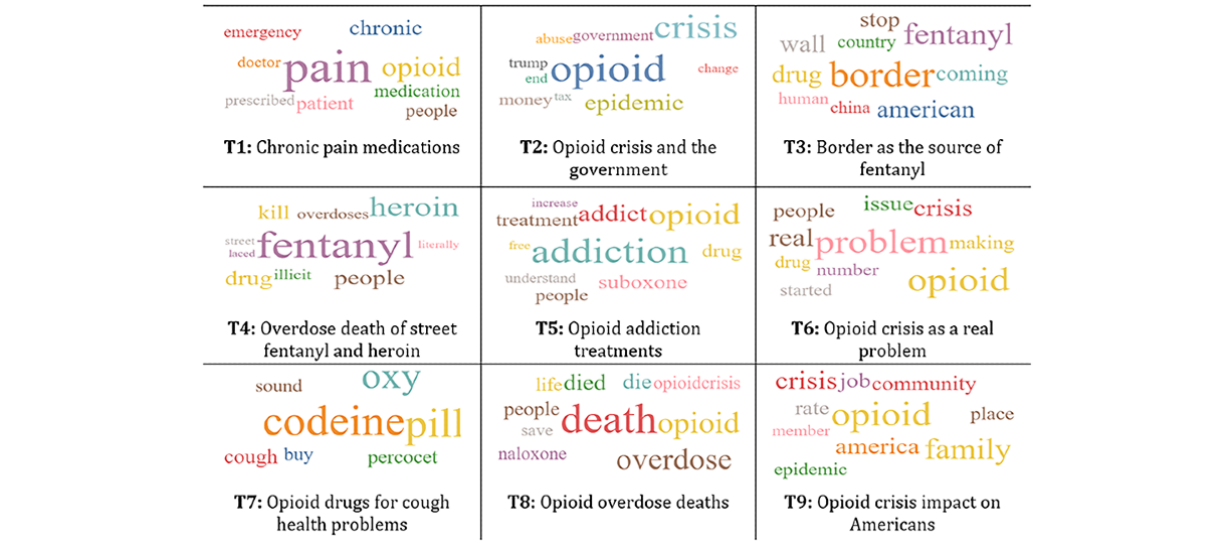
Figure 9. Top nine topic word